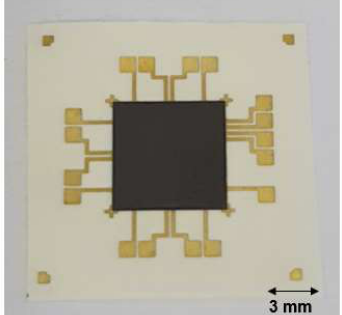
Figure 10. Image of the fabricated flexible device using the laser-assisted bonding technique.